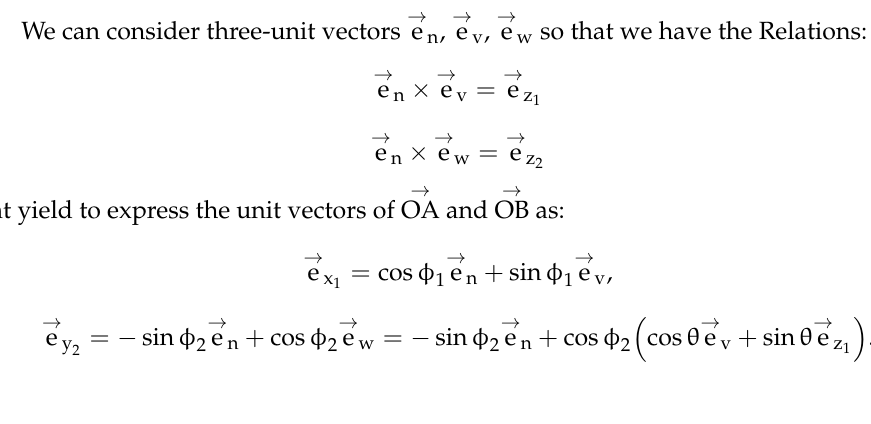
Figure 6. A general cross Hooke joint.